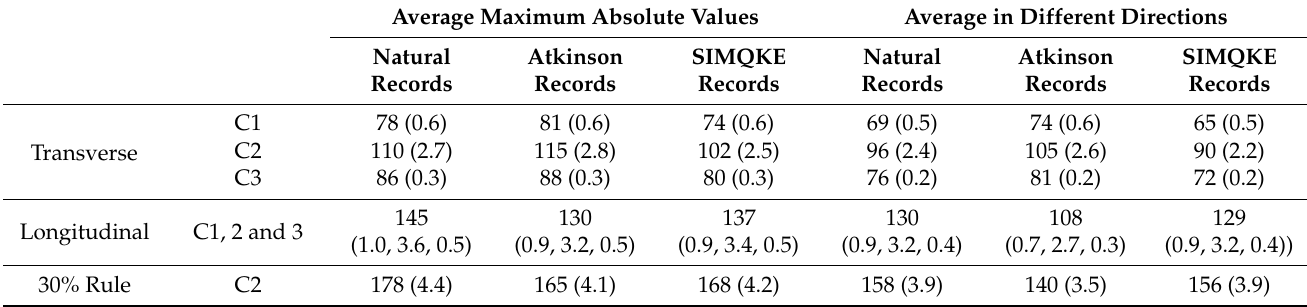
Table 6. Summary of the mean maximum absolute displacements (mm) for columns C1, C2 and C3 using 2D analysis for the irregular bridge with mean ductility demands given in